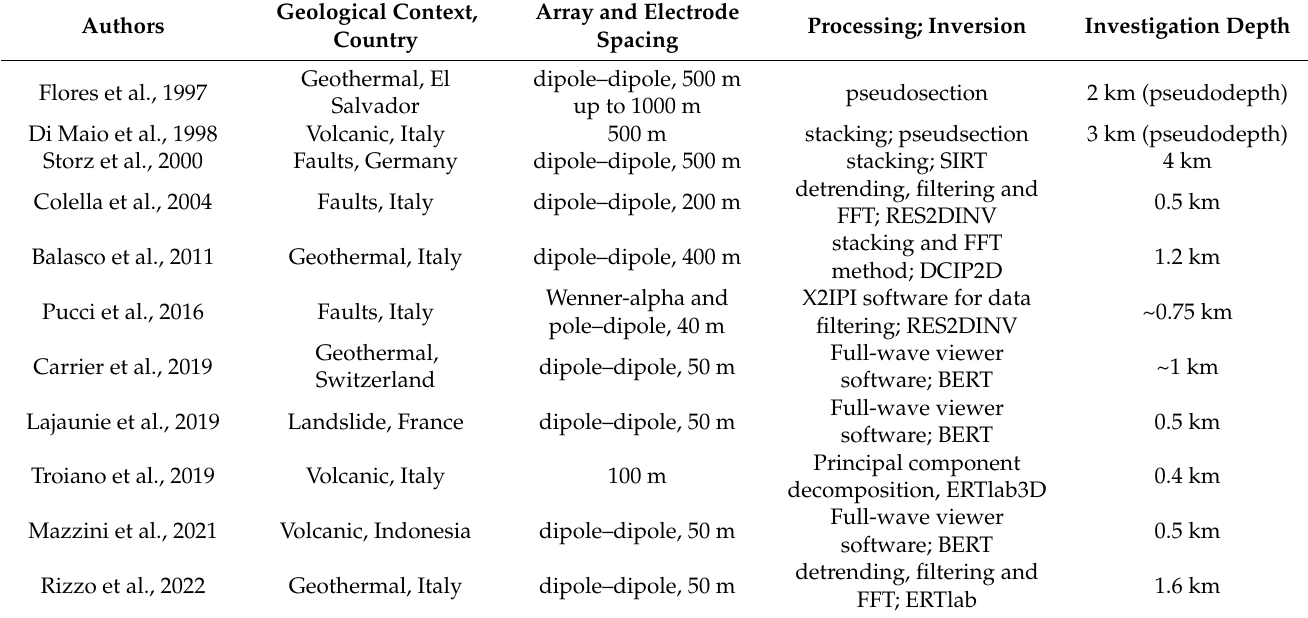
Table 1. Simplified classification of the main characteristics (geological context, array configurations, algorithms for data processing and inversion, investigation depth) of the DERT applications presented and discussed in Section 3.